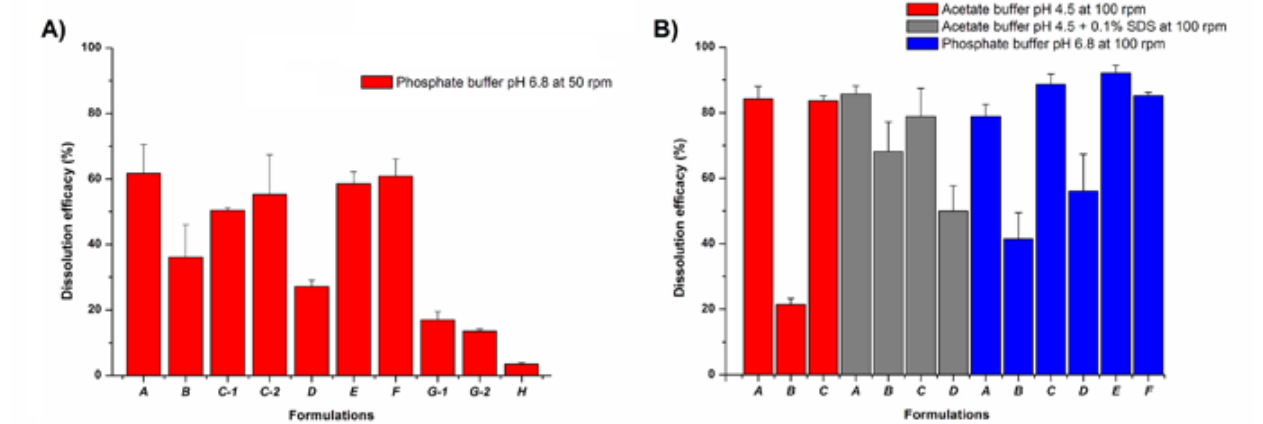
FIGURE 6 - Dissolution efficacy (%) of ROSC capsules (n=6).